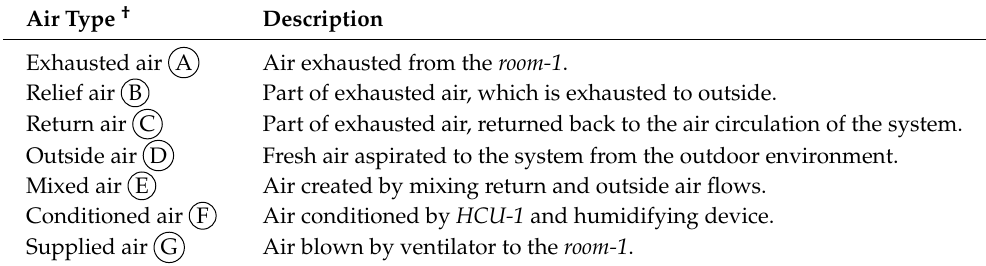
Table 2. Brief classification of air types in the HVAC